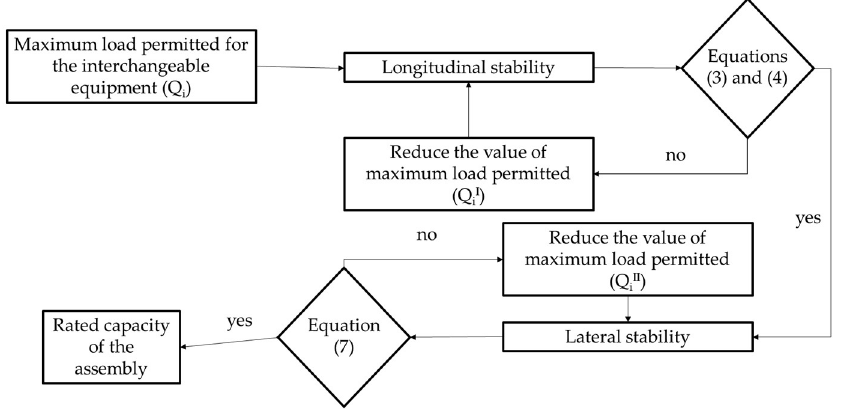
Figure 6. Analytical assessment of assembly-rated capacity.